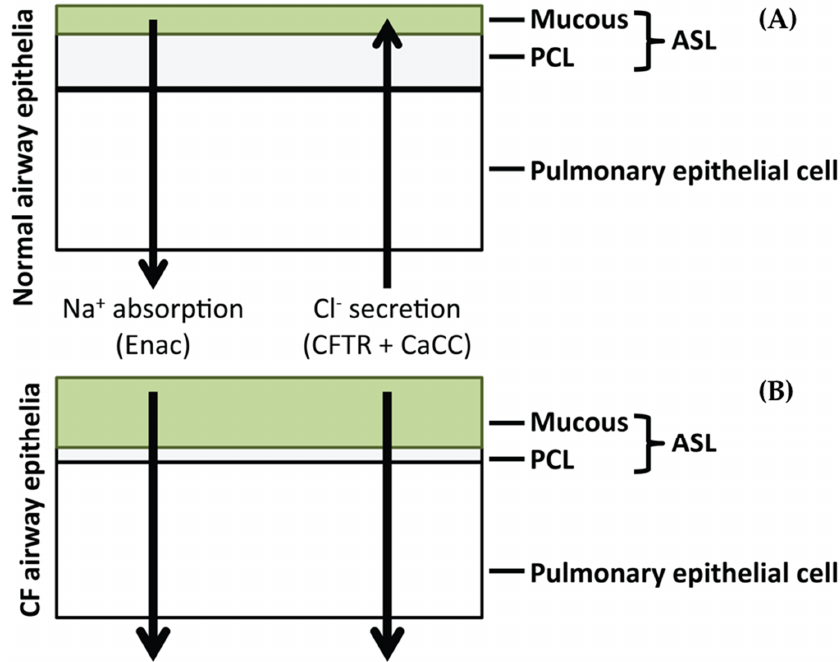
Figure 1. Events linking altered lung airway surface layer (ASL) volumes to decreased mucociliary clearance. ( A ) Normal airway surfaces contain a small mucus layer which facilitates entrapment of inhaled particles and pathogens. ASL autoregulation leads to the maintenance of the pericilliary liquid layer (PCL) which allows movement and clearance of inhaled particles and pathogens. ( B ) Hyperabsorption of Na + and ine ff ective Cl − secretion in the cystic fibrosis (CF) airway